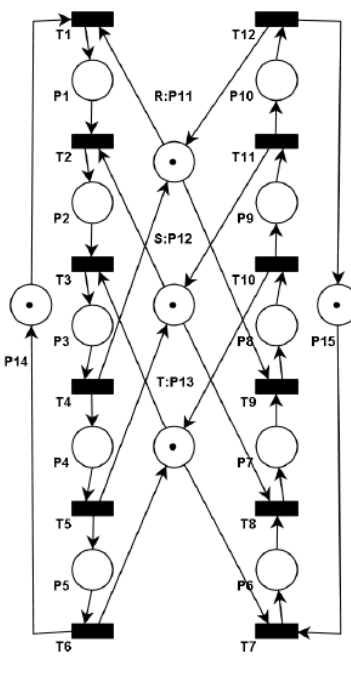
Figure 3. A BORPN Petri Net.